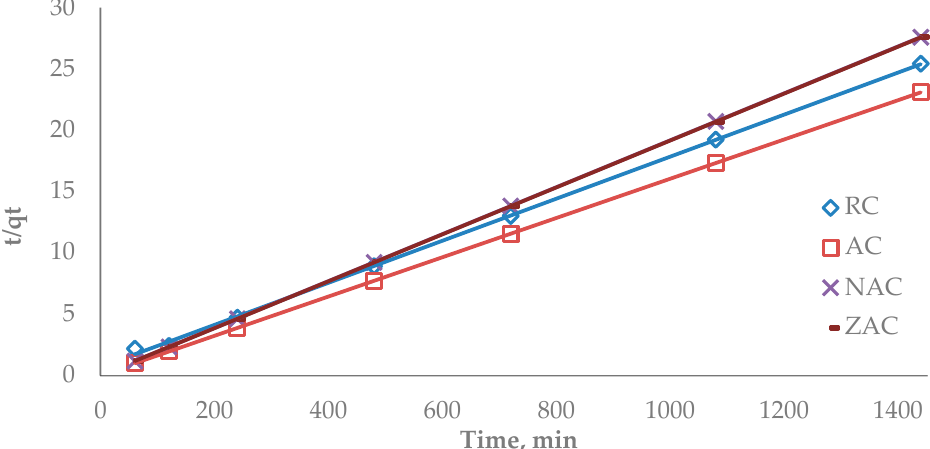
Figure 12. Plot of t/qt versus time t for the pseudo-second-order model for the adsorption of ofloxacin onto all types of cassava stem adsorbents. Table 9. Pseudo-first-order and pseudo-second-order kinetic parameters for the adsorption of ofloxacin onto all types of cassava stem adsorbents.